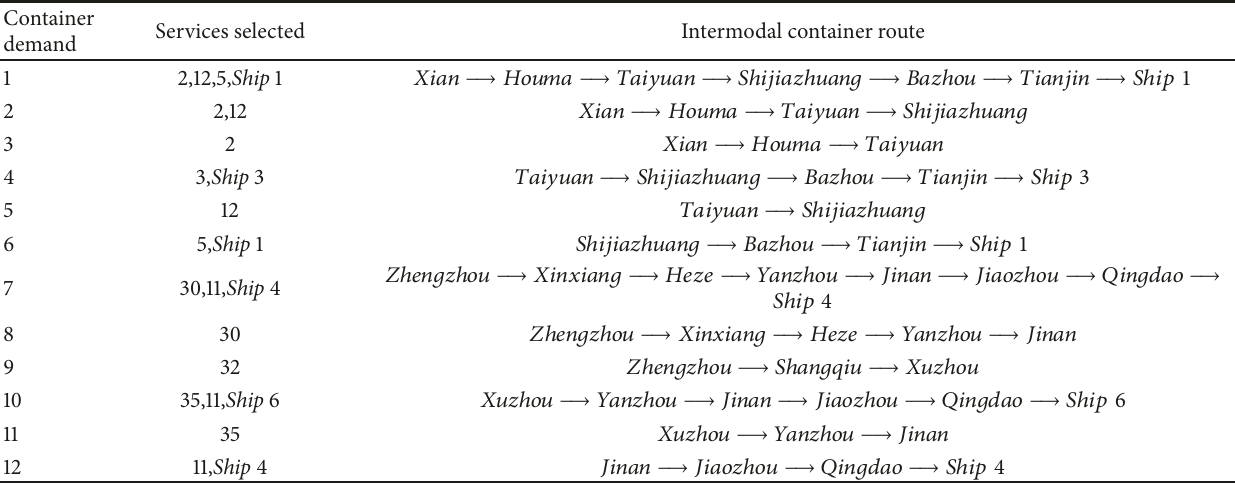
Table 5: The service and route choice of the deterministic case.